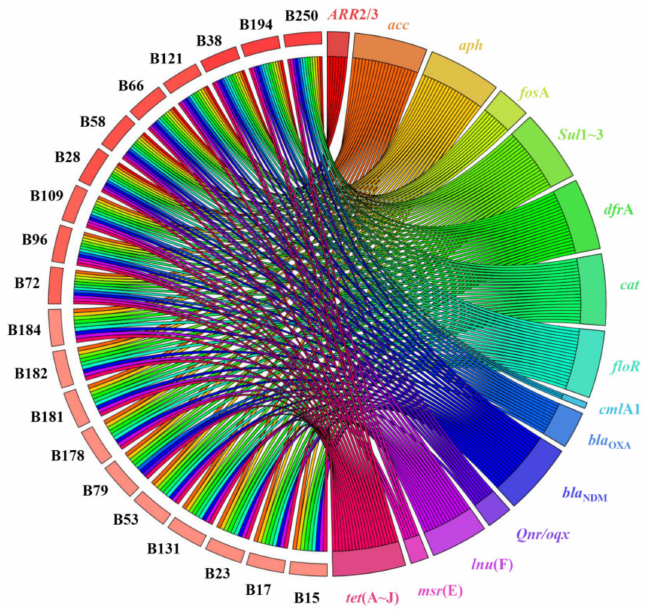
Figure 1. Antibiotic resistance genes in 20 bla NDM-1 -positive P. mirabilis. A circos representation showing the presence of antibiotics resistance genes (ARGs) (color) across isolates